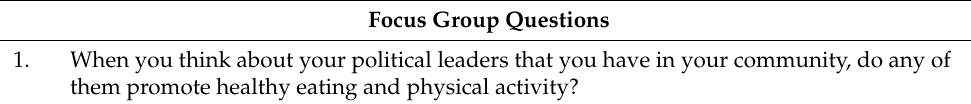
Table 1. Focus Group